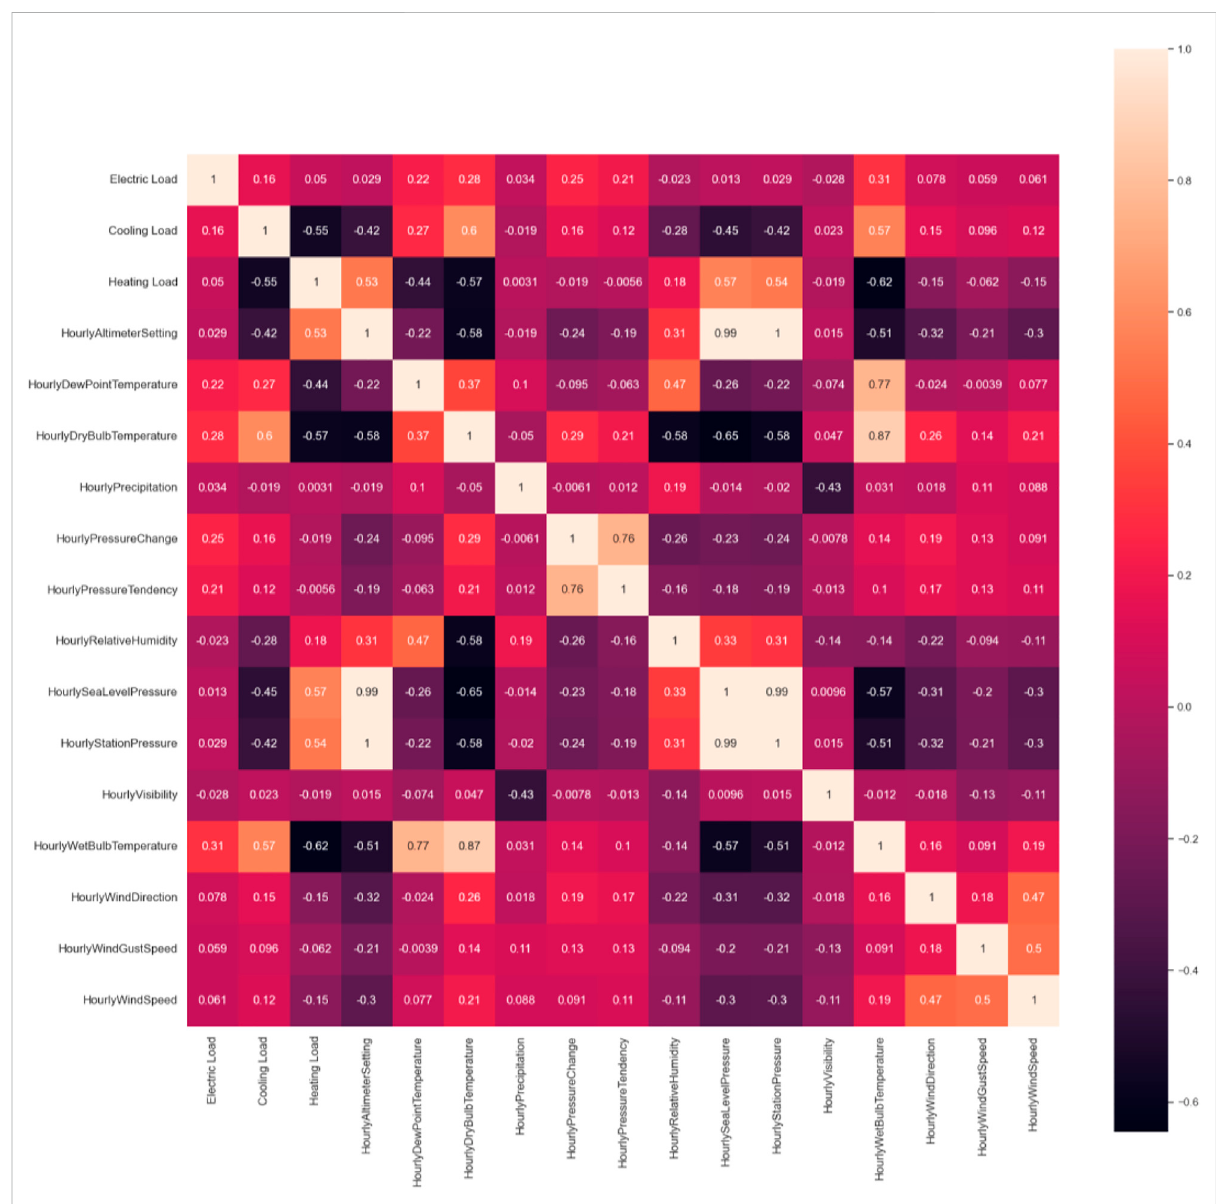
FIGURE 5 Correlation between cooling, heating and electrical load and the meteorological